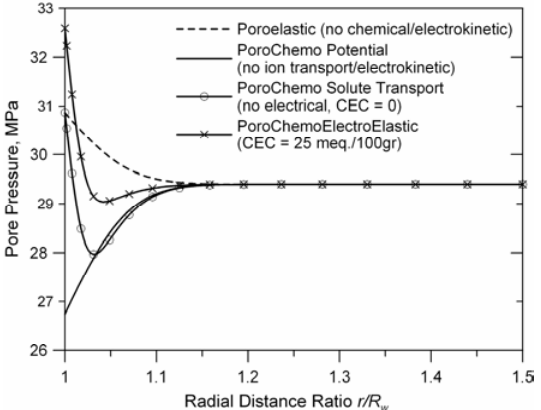
Fig. 8 – Effective radial stress distribution in the formation at various time intervals into drilling for high mud activity (low mud f . 93 > a f . 90 with electrokinetic effect. salinity): a o = 0 mud = 0